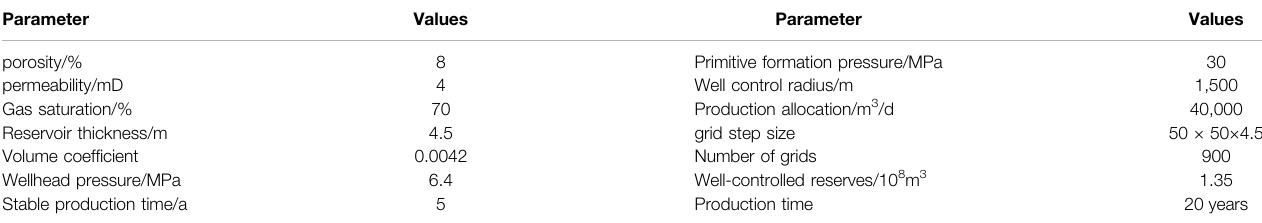
TABLE 1 | Basic parameters of typical single gas well